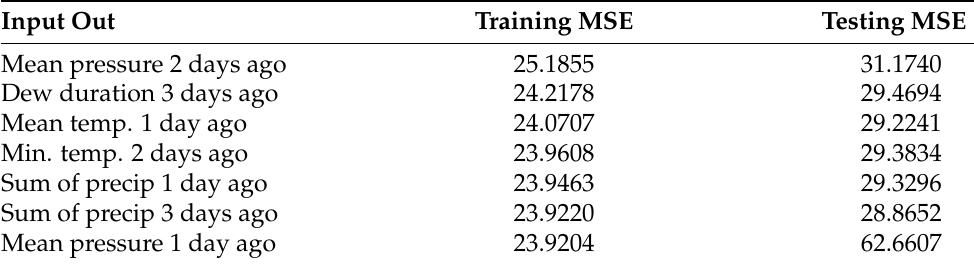
Table A4. The results of the sensitivity analysis for the prediction of the mean daily atmospheric